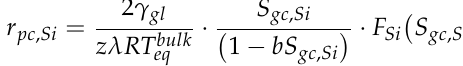
Figure 2. Effect of temperature on: ( a ) the gas/methane–liquid/water interfacial tension, γ gl ; ( b ) the methane compressibility factor, z . The corresponding pressures are those along the three-phase (H–L w –V) equilibria for the methane + water binary system.